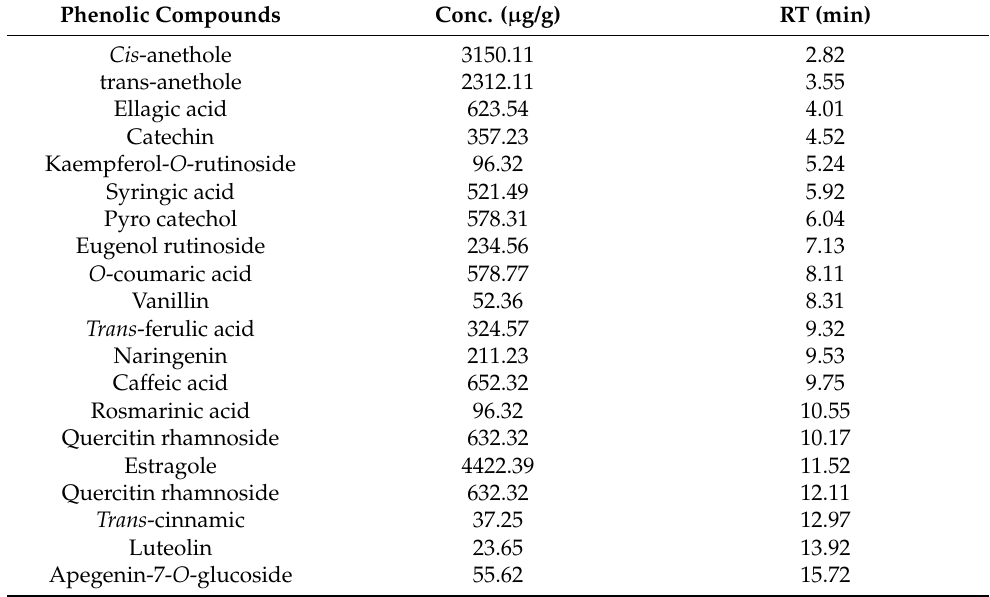
Table 9. HPLC/MS analysis of aniseed extract.